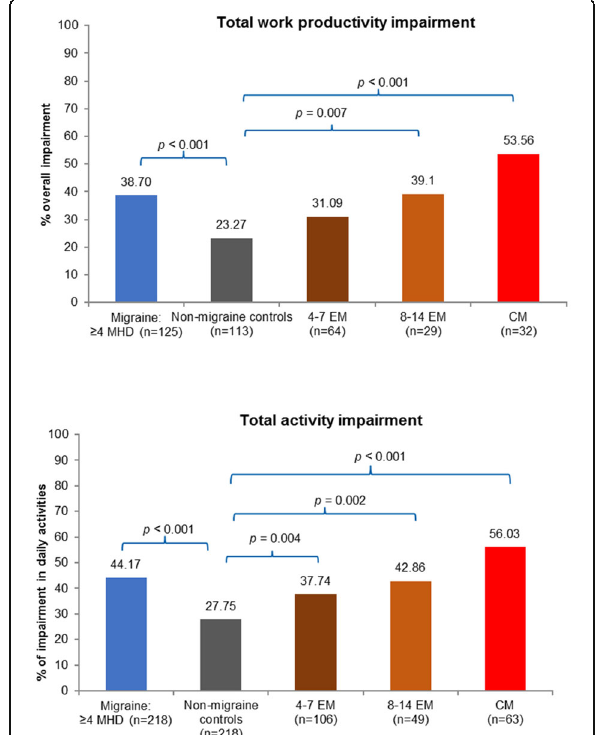
Fig. 5 Total work productivity and activity impairment in migraine subgroups vs propensity score matched non-migraine controls Mann-Whitney tests were used for analysis.CM, chronic migraine; EM, episodic migraine; MHD, monthly headache